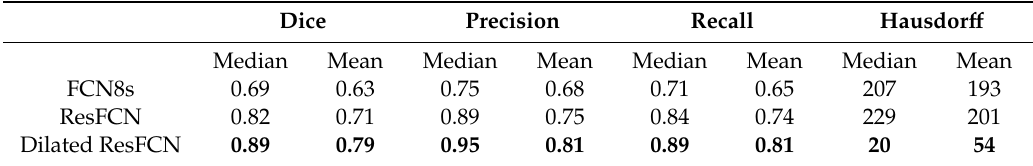
Table 2. Median and mean values recorded for di ff erent measures and segmentation methods. Dice Precision Recall Hausdor ff